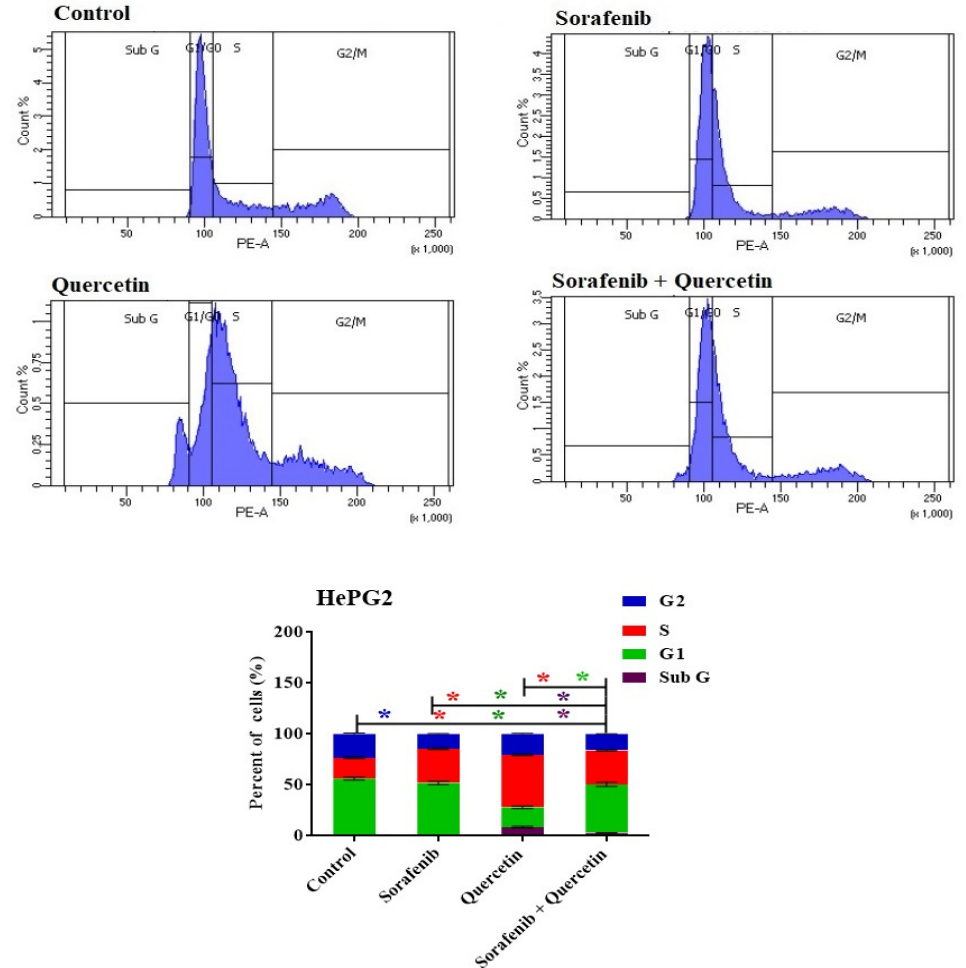
Figure 10. DNA cytometry analysis showing the effects of sorafenib and quercetin on the cell cycle distribution of HePG2 cells. Cells were exposed to sorafenib, quercetin and the mix for 48 h. Cell phases were plotted as percentage of total events. Sub-G cell population was plotted as percent of total events of cells. Data are presented as mean ± SEM for three replicates ( n = 3). The differences of events from each respective control are considered significant at * p < 0.05.